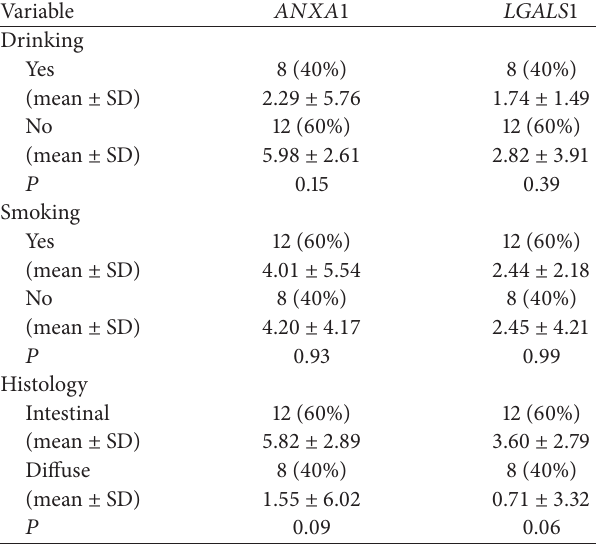
Table 4: Relative expression of ANXA1 and LGALS1 mRNA in the gastric adenocarcinoma group related to drinking, smoking, and histological type of